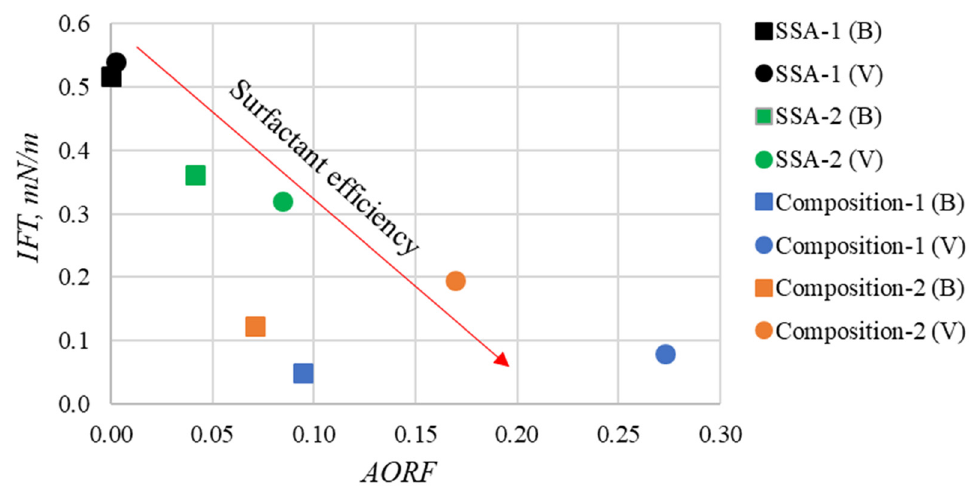
Figure 10. Comparison of the effect of surfactants on IFT and additional oil recovery. Rectangles—Vereian horizon, Circles—Bashkirian stage.